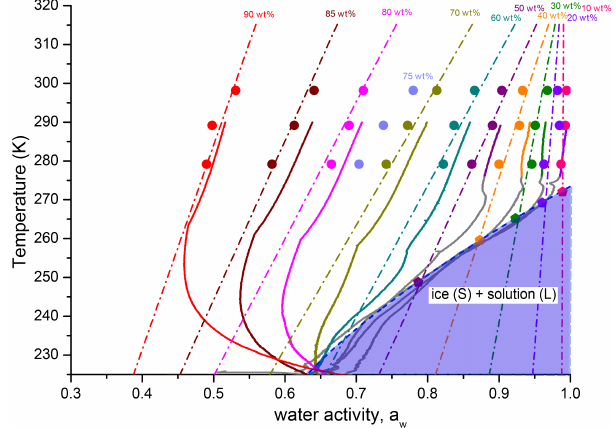
Figure 4. Experimental water activities vs. temperature for aqueous 2-(2-ethoxyethoxy)ethanol solutions. The different colours indicate the solution compositions inwt% of the organic component. The solid curves show data derived from the total gas phase pressure measurements. The coloured portion of the solid curves represents the temperature range for which the measurements are considered reliable. Water activity data obtained from DSC measurements on the water-ice melting curve from Zobrist et al. (2008) are repre- sented by solid pentagons. The solid circles show the data from bulk a w measurements with the water activity meter. The dash–dotted lines show the composition- and temperature-dependent a w param- eterisation by Zobrist et al. (2008). The blue dashed line is the ice melting curve (Koop and Zobrist,